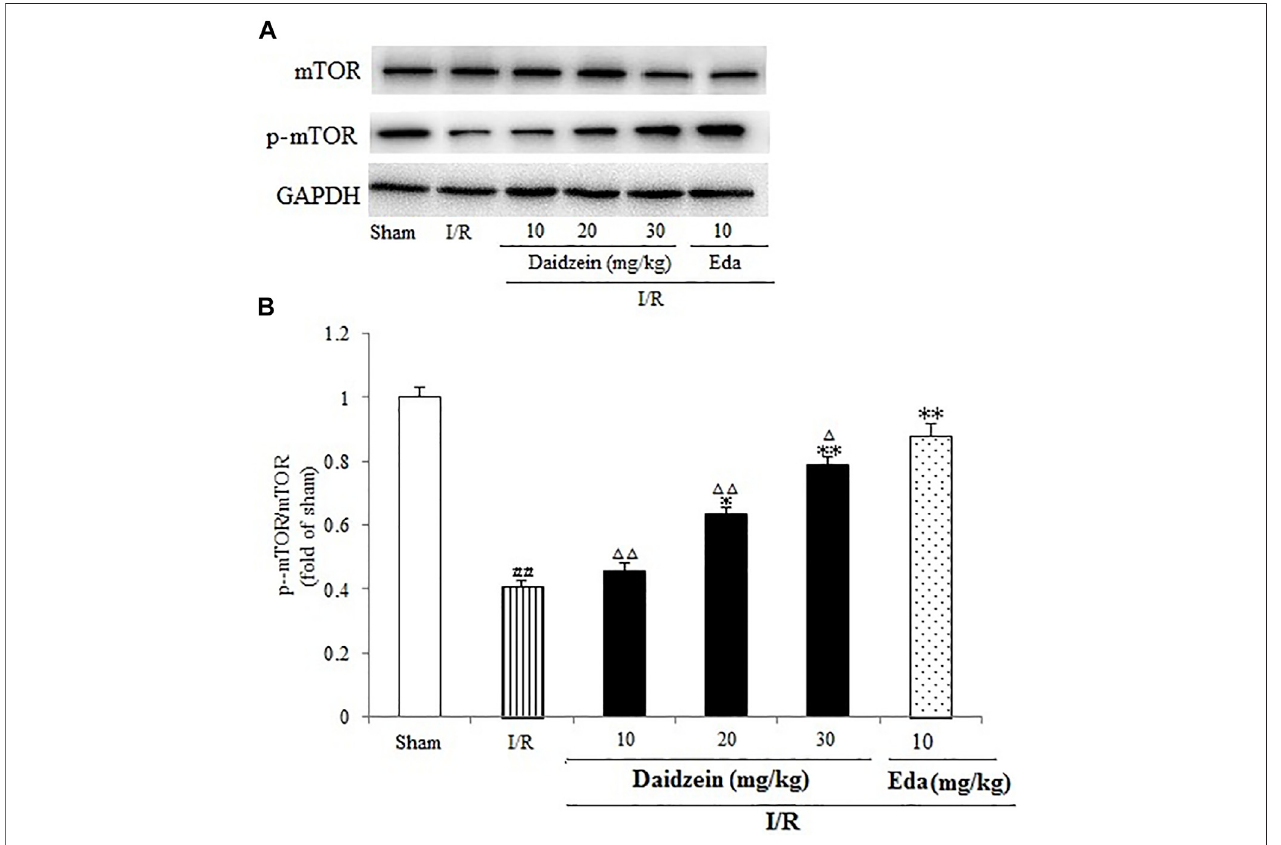
FIGURE8| ImmunoblottinganalysisindicatingtheBcl-2/BADratioinrats ’ braininfarctregion. (A) RepresentativeproteinbandsofBcl-2andBAD. (B) RatioofBcl- 2/BAD. Values are indicated as means ± standard errors of the means (SEMs; n (cid:2) 3). ## p < 0.01 noticeably distinct from Sham; ** p < 0.05, noticeably distinct from I/R; △ p < 0.05, △△ p < 0.01, compared with the Eda